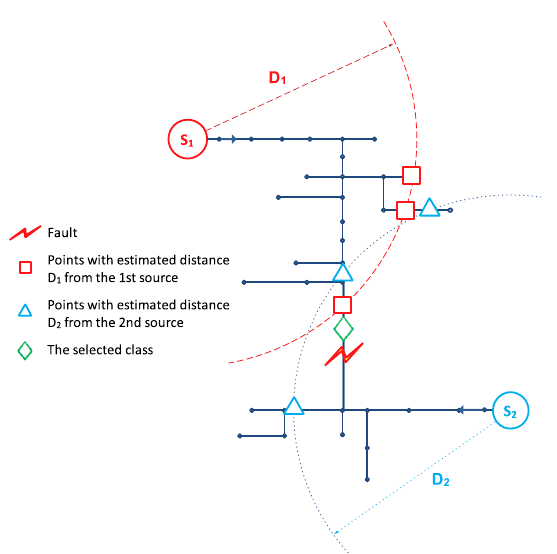
Fig. 3 The difficulty of interpretation of ANN outputs in finding a specific fault location